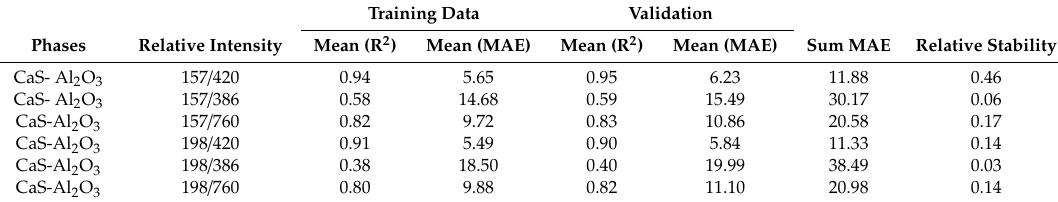
Table 8. Evaluation of the coe ffi cient of determination (R 2 ) and mean absolute error (MAE) for the prediction and validation between the phase content and relative intensity of the Raman peaks and phase content for CaS- Al 2 O 3